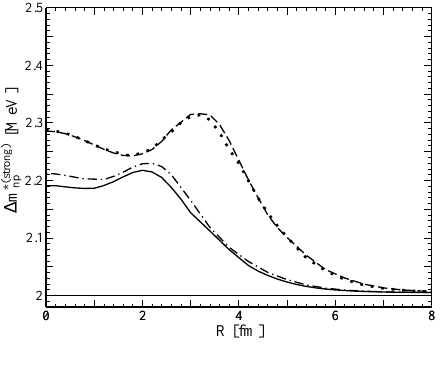
Fig. 3. The dependence of ∆ m ∗ (strong) np on the distance R between the center of the skyrmion and the center of the nucleus. The notations and input are the same as in Fig. 2, with the exception that the horizontal line marks the free space value ∆ m (strong) np = 2 . 0 MeV. Figure from Ref. [44].